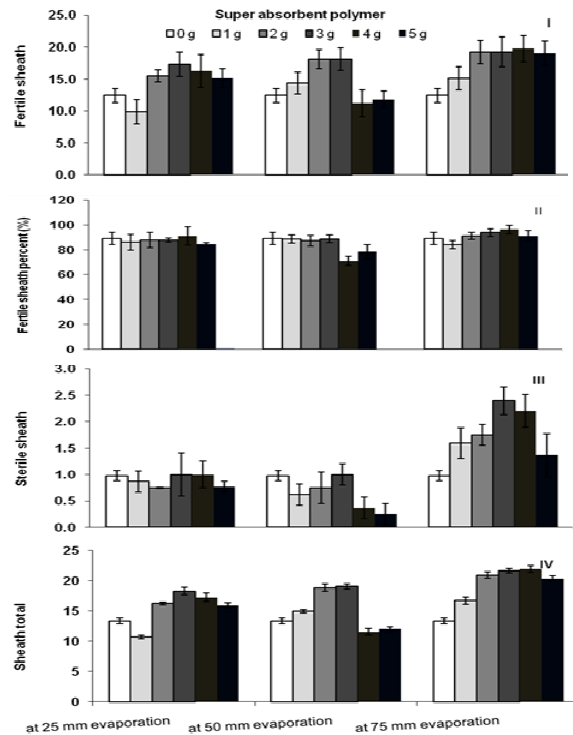
Fig. 3. Means comparisons of fertile sheath (I), fertile sheath percent (II), Sterile sheath (III) and sheath total (IV) at different levels of super absorbent polymer and drought